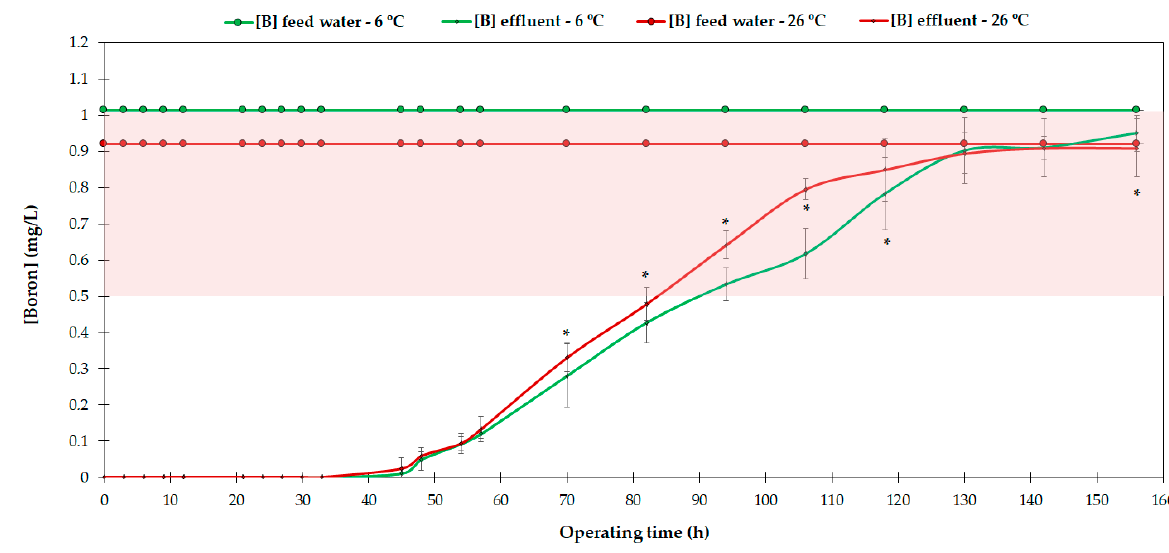
Figure 5. Boron concentration in the feed water and effluent during the test performed. The shaded area represents the phytotoxicity threshold of woody crops. * Significant differences at p ≤ 0.05.